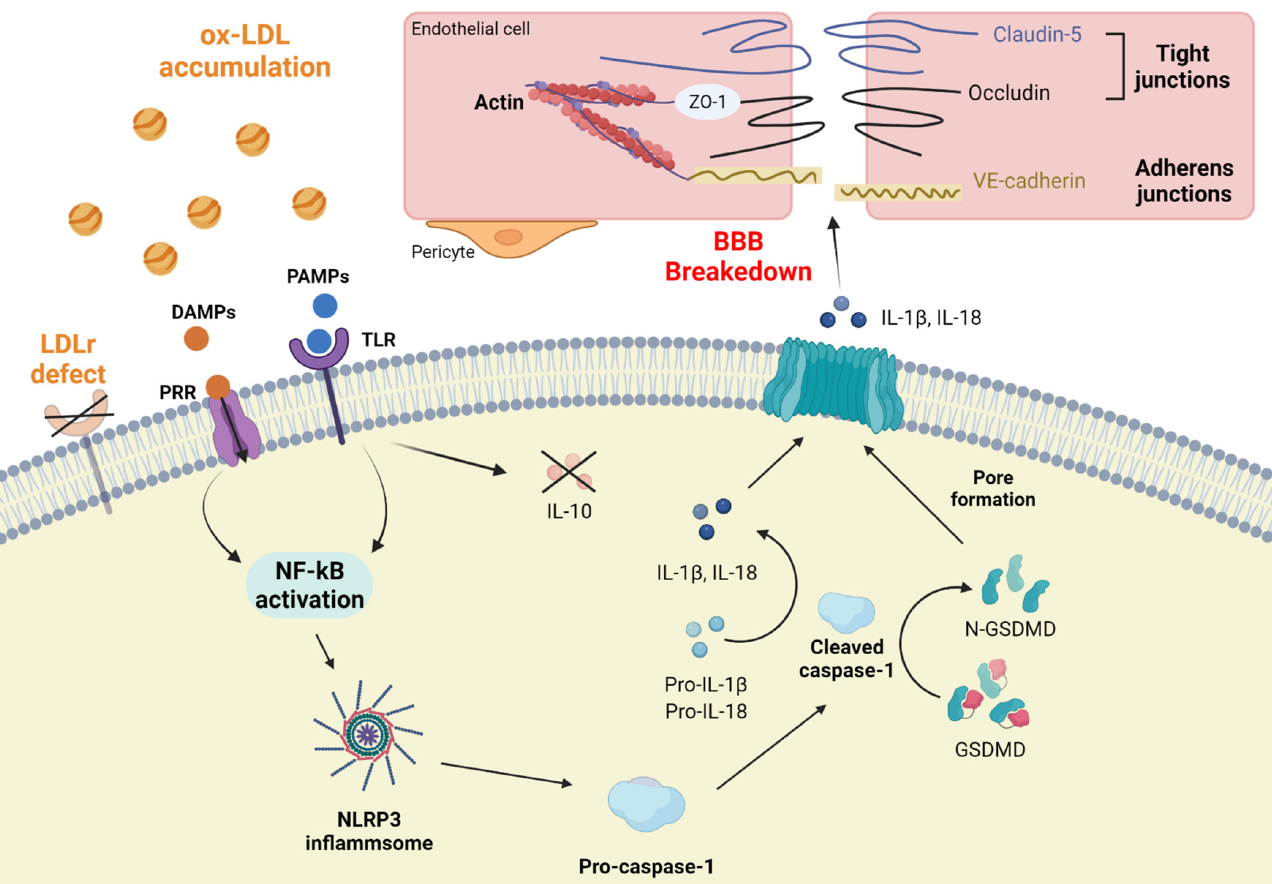
Figure 2. Blood–brain-barrier (BBB) breakdown due to inflammation. BBB breakdown process induced by NLRP3-mediated inflammation.